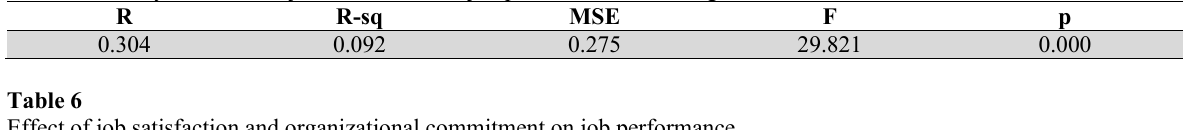
Effect of job satisfaction and organizational commitment on job performance Coeff SE t p Constant